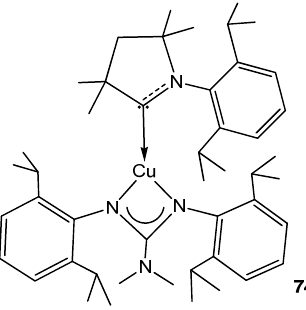
Figure 46. Phosphorescent carbene copper guanidinato compound.